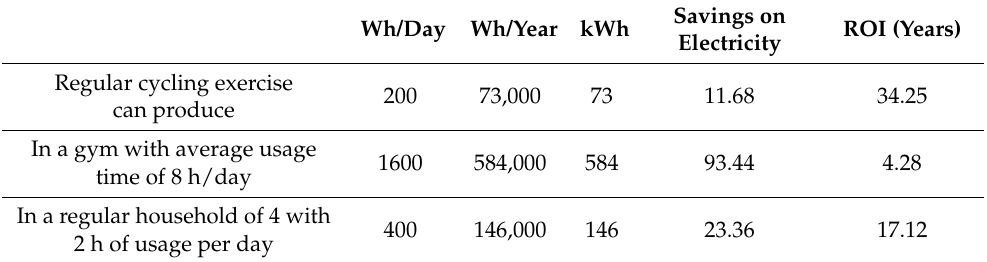
Table 7. Return of Investment